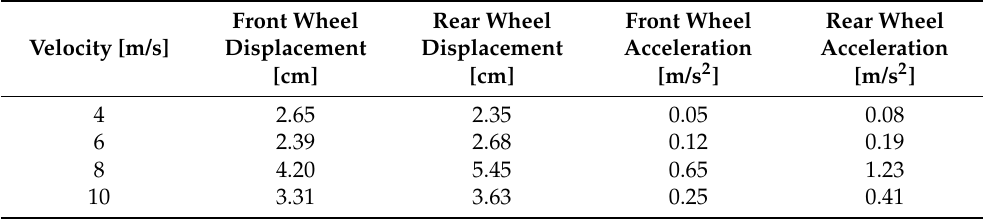
Table 4. Maximum net displacement and acceleration of front and rear wheels at di ff erent speeds.